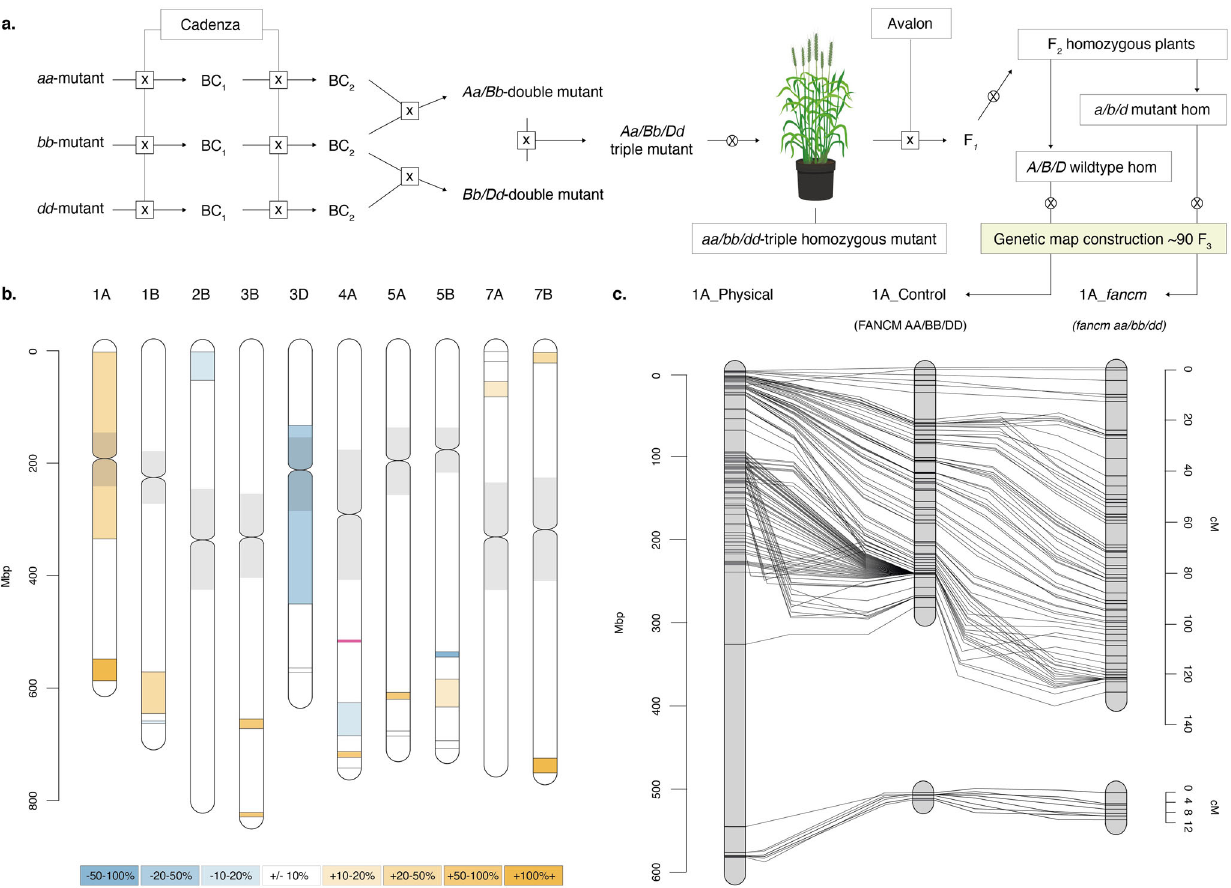
Fig. 5 De fi nition of the hexaploid marker-based recombination analysis highlighting Chromosome 1 A as an example. a Crossing schematic for the development of the triple homozygous mutant and F 3 mapping populations fi xed at fancm for either wild type or mutant alleles. b Segregating regions in both F 3 populations aligned and ordered by RefSeqv1.0 coordinates (Mbp), fl anking markers indicated by lines. Increasing regions (>10%) are highlighted with shades of orange and decreasing regions (< − 10%) in blue, with neutral regions ( − 10 to + 10%) in white. The location of fancm on chromosome 4 A is indicated by a red line and centromeric regions are shaded in gray. c Comparison of the genetic maps of the F 3 populations for chromosome 1 A (cM). The control population is aligned to the physical positions (Mbp) to illustrate chromosomal